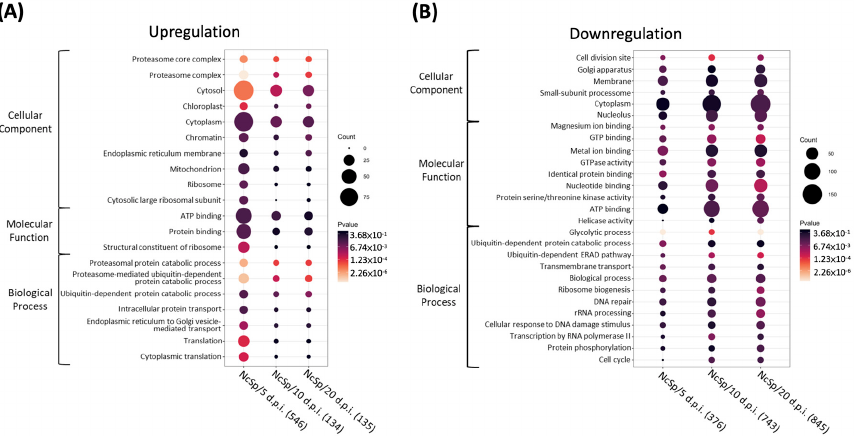
Figure 3. Dot plot of N. ceranae Gene Ontology (GO) term enrichment analysis, showing the enriched pathways with p < 0.05. ( A ) Upregulated DEGs; ( B ) downregulated DEGs. Each comparison is indicated at the bottom. The total number of regulated genes within the GO pathways selected on the dot plot are indicated in brackets. Colors indicate the p values from Fisher’s exact test, and the dot size is proportional to the number of DEGs and common DEGs in the pathway.